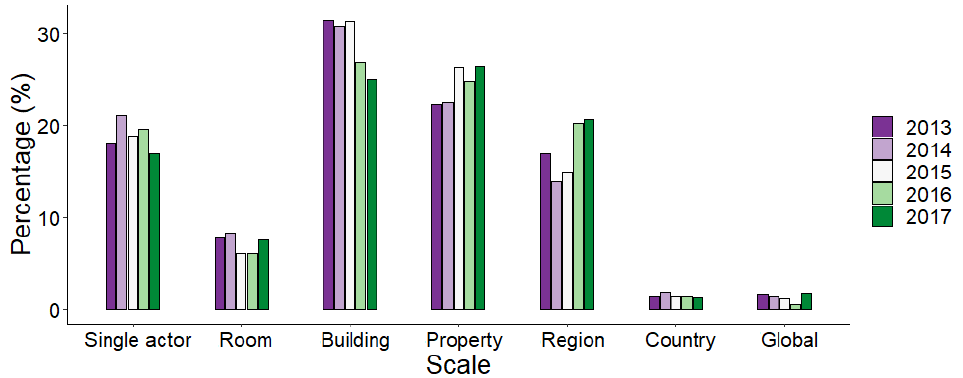
Figure 41. Deployment distribution between scale of the goal network and year.